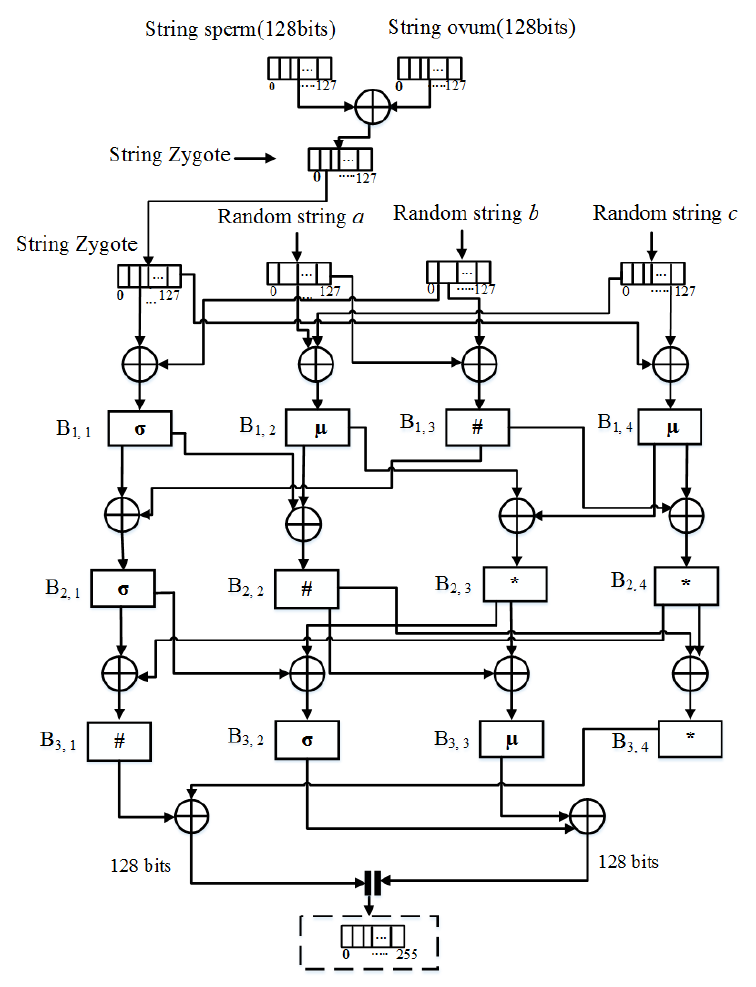
Figure 1. Omega network-based DNA key generation. Notes: *—DNA XOR rules; µ—mRNA mapping rules (first letter, second letter); σ—mRNA mapping rules (second letter, first letter); #—Complementary mapping rules.